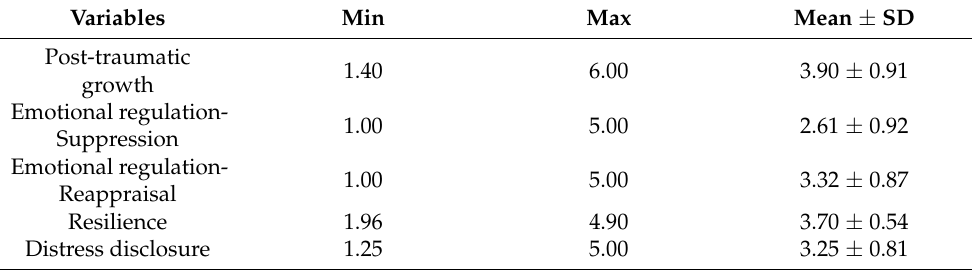
Table 2. Levels of emotional regulation, resilience, distress disclosure, and post-traumatic growth (N =